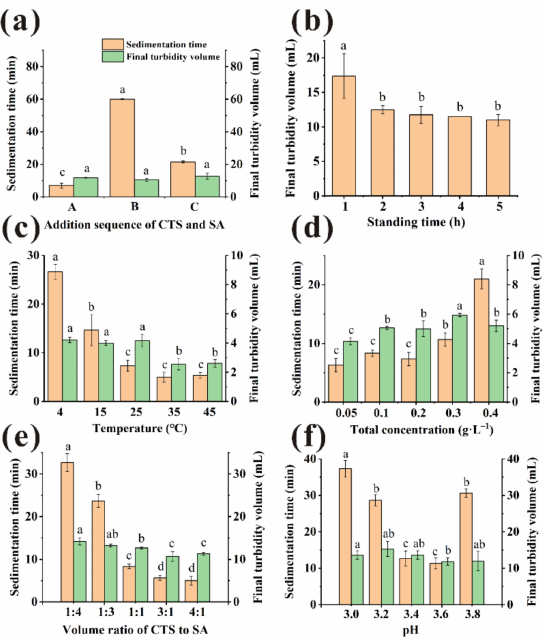
Figure 3. Various factors (( a ): addition sequence, ( b ): standing time, ( c ): temperature, ( d ): total concentration, ( e ): volume ratios, ( f ): pH) to influence sedimentation time and final turbidity volume. (Different little letters mean a significant difference at the level of